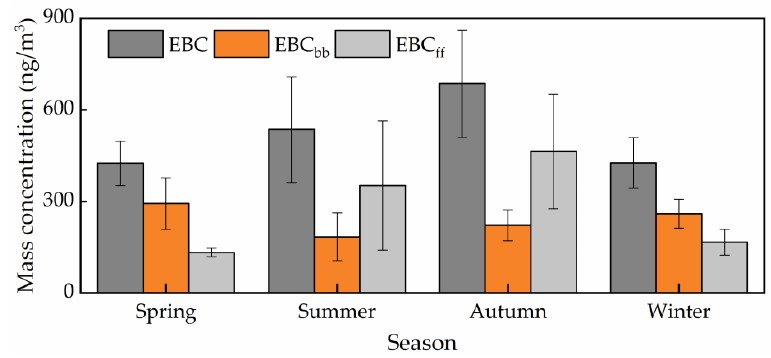
Figure 8. Seasonal variation of EBC, EBC bb , and EBC ff .